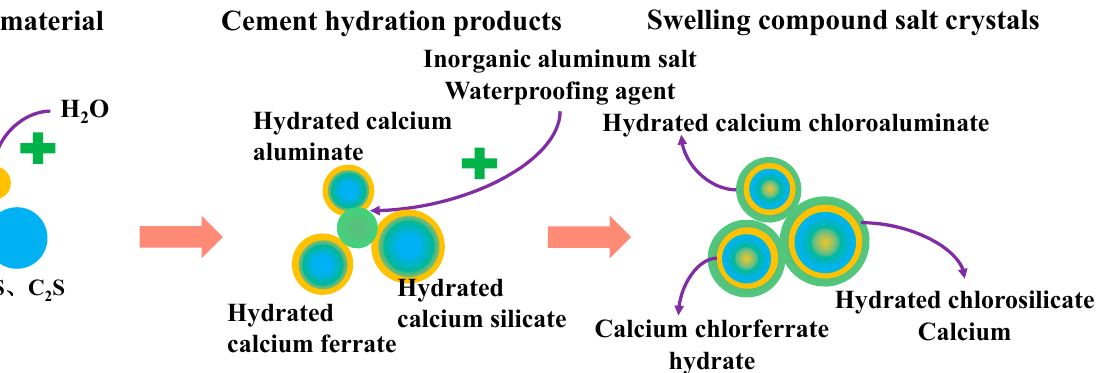
Figure 11. Sodium methyl silicate action model.